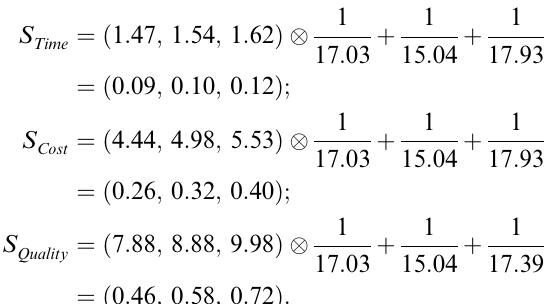
The priority weighs of the criteria were computed using FSA. From Table 6, the value of fuzzy synthetic extent with respect to each criterion was calculated